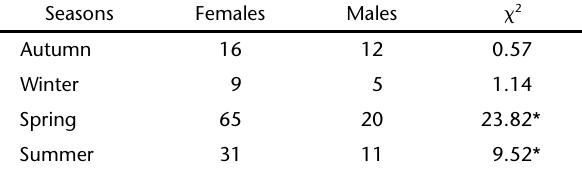
Table III. Seasonal sex ratio of A. lineatus specimens in the Paranaguá Bay, state of Paraná. * significant values (df = 1, p <